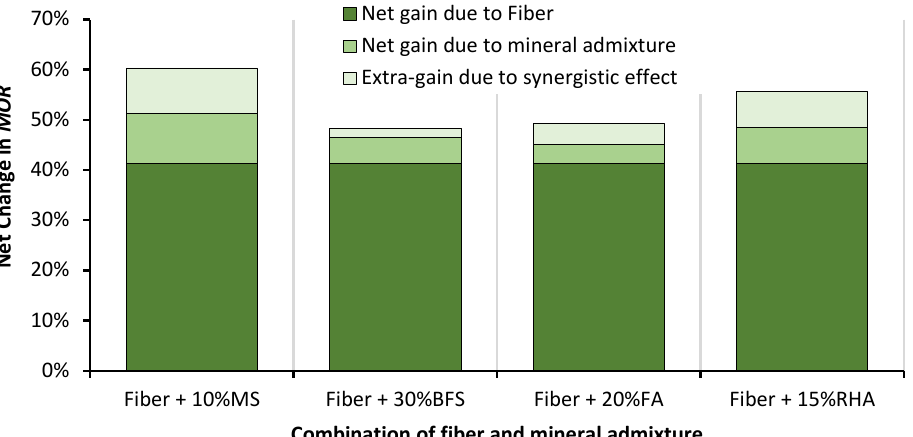
Figure 15. The net change in the MOR of RAC due to the addition of mineral admixtures and glass fibers (MS, BFS, FA, and RHA).